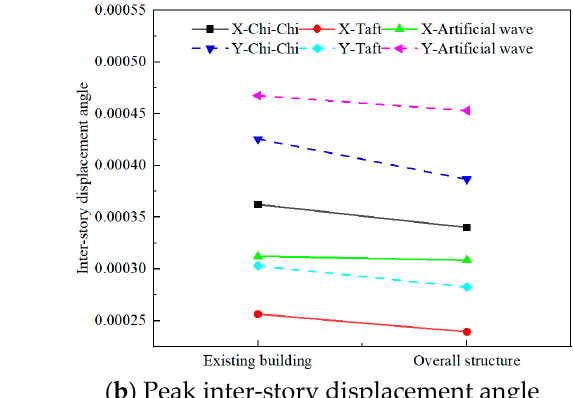
Figure 5. Result of frequent earthquakes time history analysis.